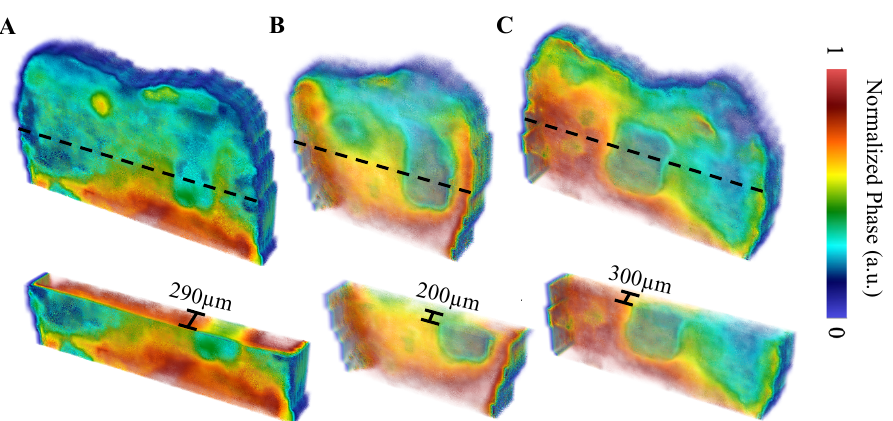
Figure 7. TC-PCT LIOP reconstructions with partial transparency of the ( A ) buccal, ( B ) distal, and ( C ) lingual surfaces using a 0.2–0.6 Hz, 12 s chirp with 40 ms pulse width and 20 ms slice width. All reconstructions were filtered using the histogram equalization filter [13] to improve the caries visibility. The dashed black lines indicate the regions of the cross-sectional cuts (displayed underneath the whole volume). Volumes are displayed using software available online [31].